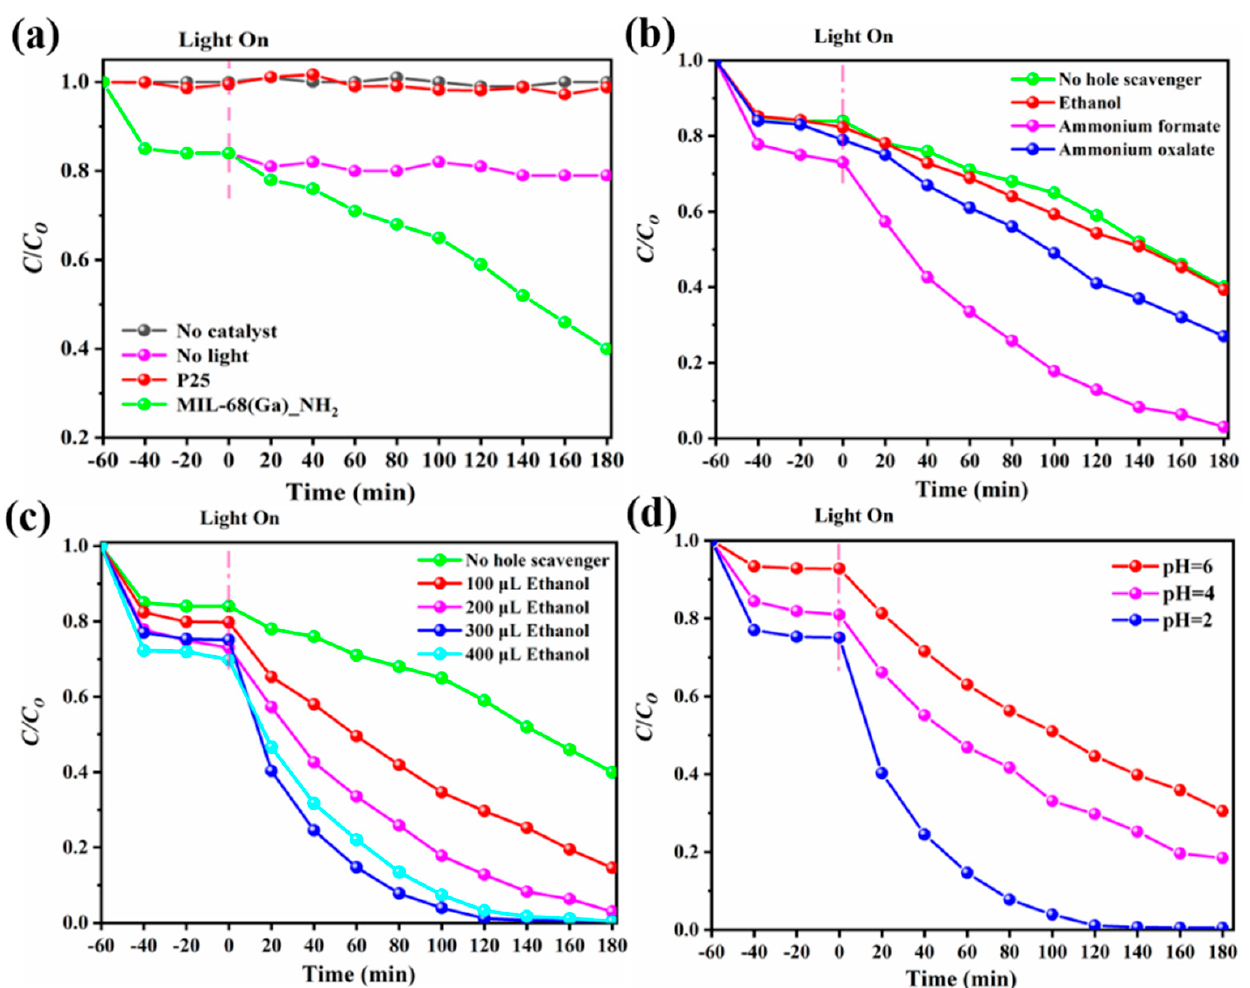
Figure 5. ( a ) Photocatalytic reduction of aqueous Cr(VI) under different conditions. ( b ) Photocatalytic activities of MIL–68(Ga)_NH 2 for the reduction of aqueous Cr(VI) in the presence of various hole scavengers. ( c ) Photocatalytic activities of MIL–68(Ga)_NH 2 for the reduction of aqueous Cr(VI) in the presence of different amount of ethanol hole trapping agent. ( d ) Photocatalytic activities of MIL–68(Ga)_NH 2 for the reduction of aqueous Cr(VI) at different pH values.